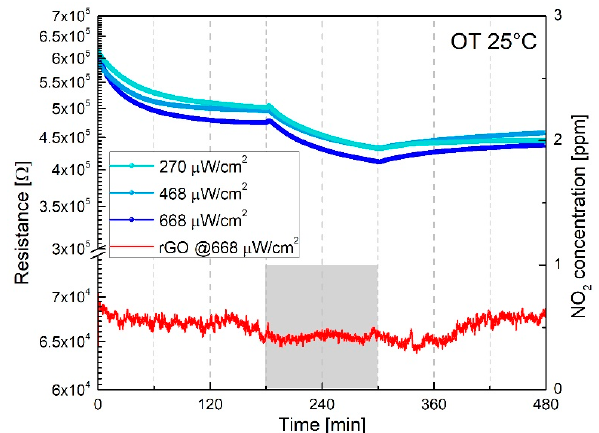
Figure 6. Response to 1 ppm NO 2 in dry air of WS 2 -decorated rGO and bare rGO film (red curve) irradiated by Purple–Blue ( λ = 430 nm) light at different power densities (270 μ W/cm 2 , 468 μ W/cm 2 , irradiated by Purple–Blue ( λ = 430 nm) light at di ff erent power densities (270 µ W / cm 2 , 468 µ W / cm 2 , 668 μ W/cm 2 ). 668 µ W / cm 2